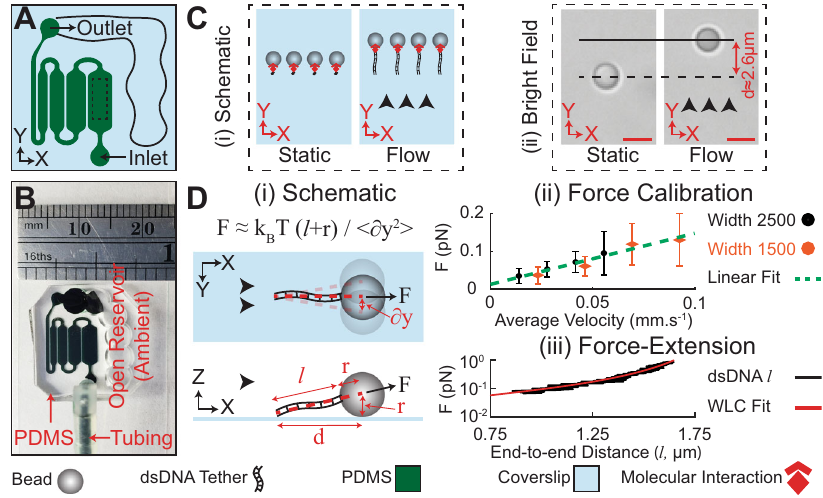
n =23 beads in the 1500 µ m wide channel were monitored over three independent experiments under different fl ow rates. Error bars represent standard deviation. The calibration line (red dash line) indicated a linear relationship between drag force and perfusion rate with slope of ~1.4±0.2pNsmm − 1 . Error bars represent standard deviation. (iii) Force-extension examination of single tethers under vary- ing F. The tether length (l) was well described according to the worm-like chain model(solidredline,persistencelength=56±8nm,contourlength=1.8±0.1 µ m). Black arrowheads denote fl ow direction. Scale bars are 2 μ m. Source data are provided as a Source Data fi